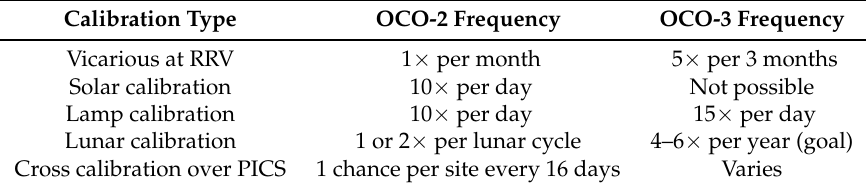
Table 1. OCO-2 and OCO-3 inflight radiometric calibration/validation methodologies and